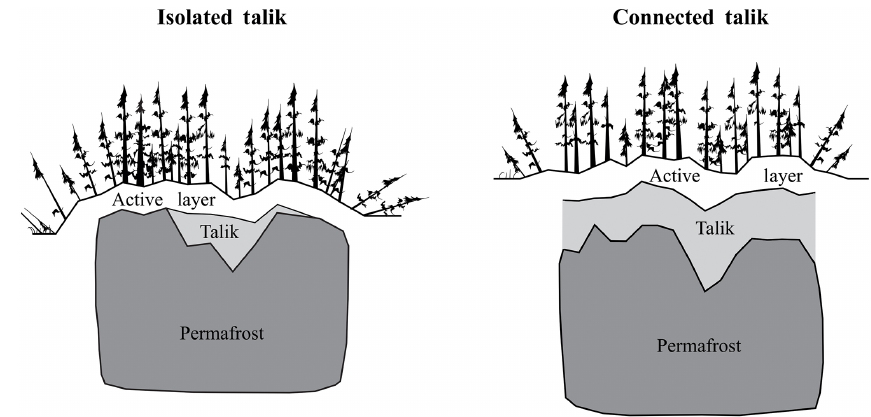
Figure 7. Taliks can either be isolated systems within a plateau or continuous features across a plateau that connects adjoining wetlands. Adapted from Connon et al.